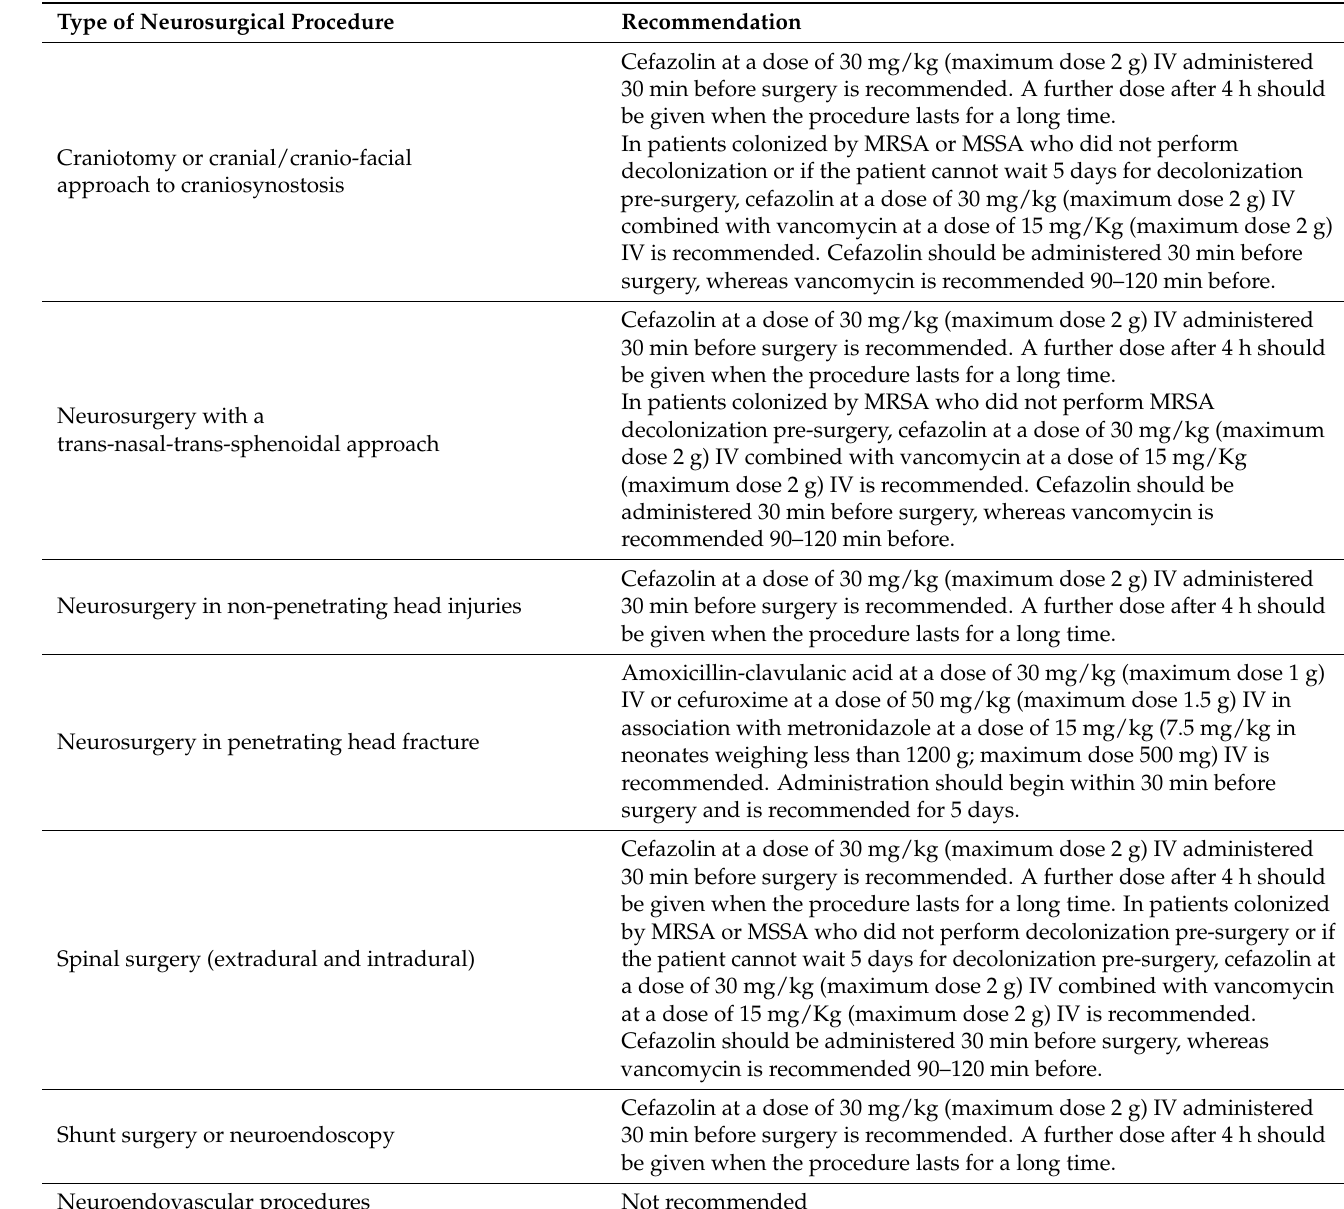
Table 1. Recommendation of antibiotic prophylaxis in neonatal and pediatric